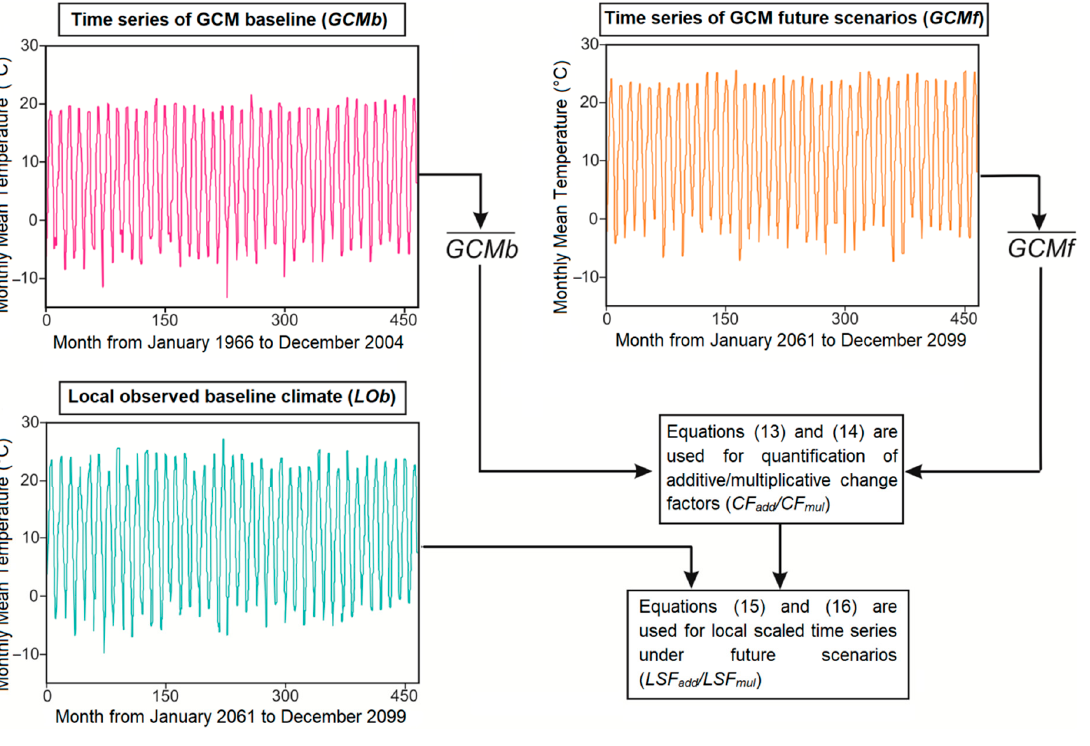
Figure 4. Method to evaluate future scenarios by applying the multiplicative and additive change